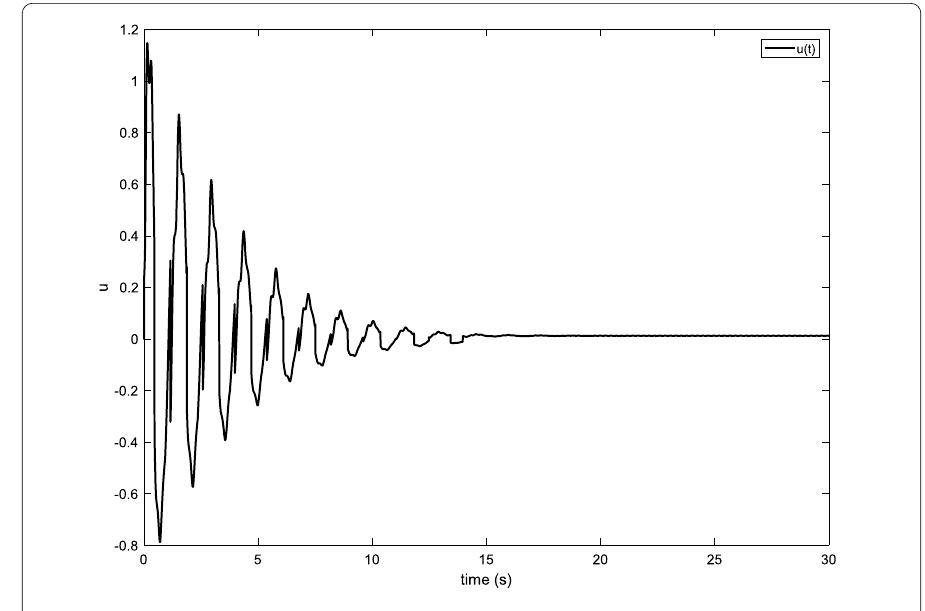
Figure 10 Time evolution of the applied control rule